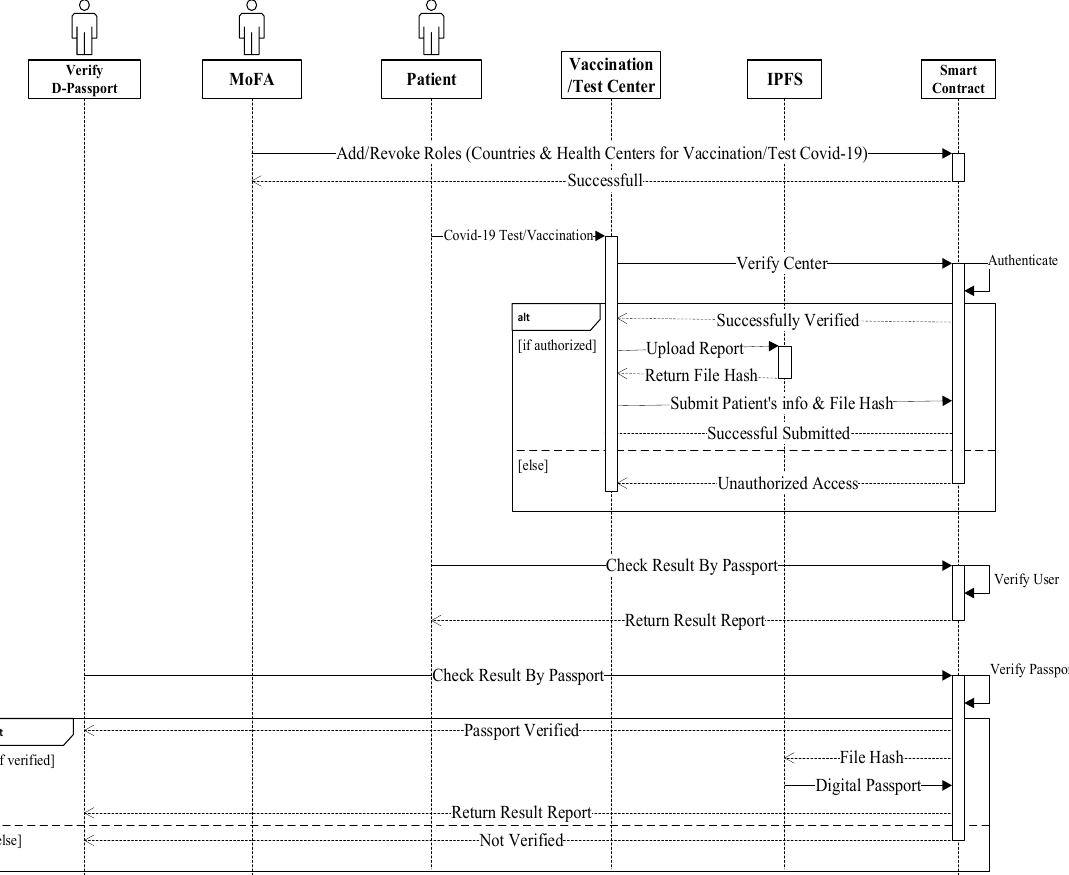
Figure 8. Sequence process for digital Figure 8. sequence process for digital passport.